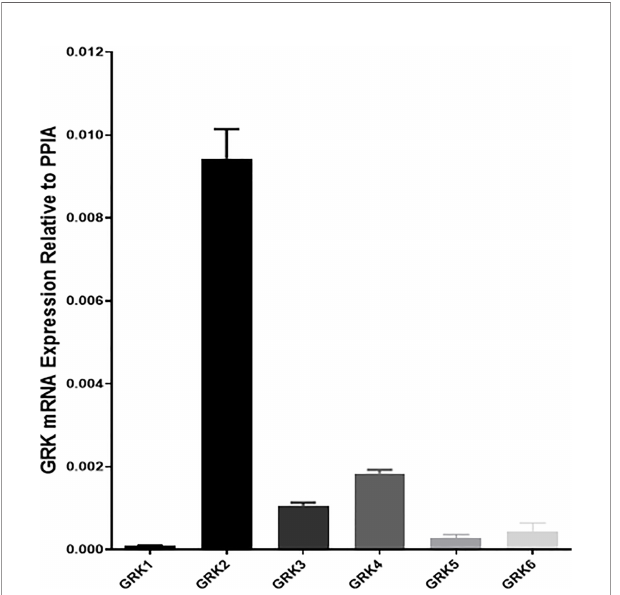
FIGURE 3 | Real-time PCR assay of mRNA abundance of GRK1-6 in mouse pancreatic islets. Cyclophilin A (PPIA) was used as a housekeeping gene, and quanti fi cations were conducted using the 2 DD Ct method. Samples were run in duplicates.